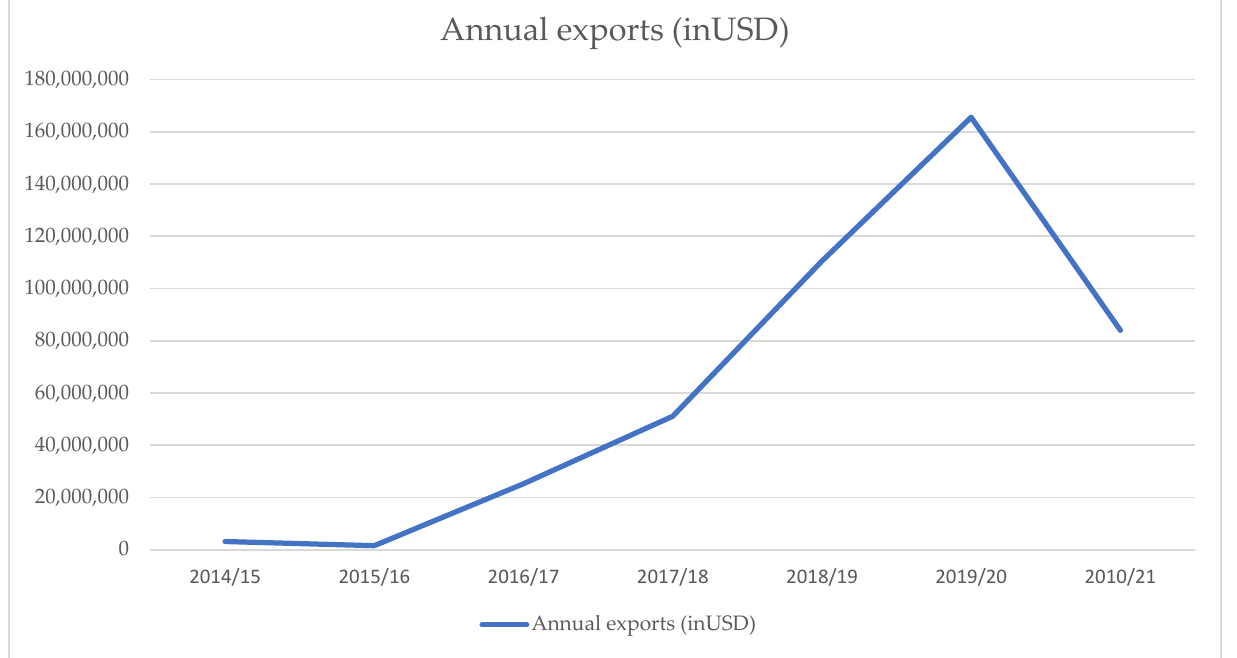
Figure 6. The export amount of IPDC-owned IPs (2014/15–2020/21); Source: IPDC, computed by authors; 2020.